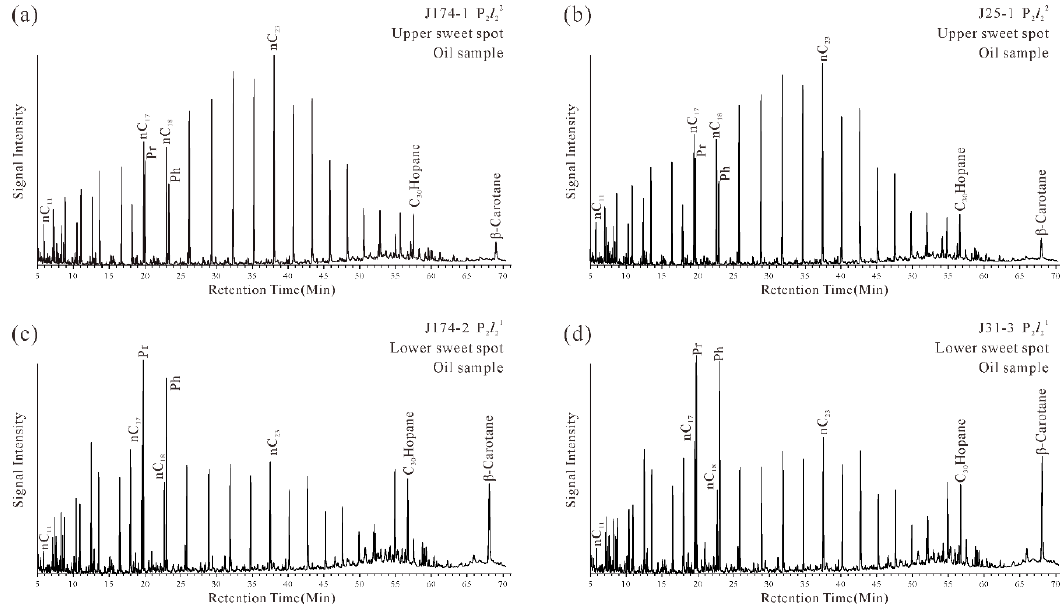
Figure 4. Representative gas chromatograms of whole oil samples from the ( a , b ) upper sweet spot and ( c , d ) lower sweet spot.